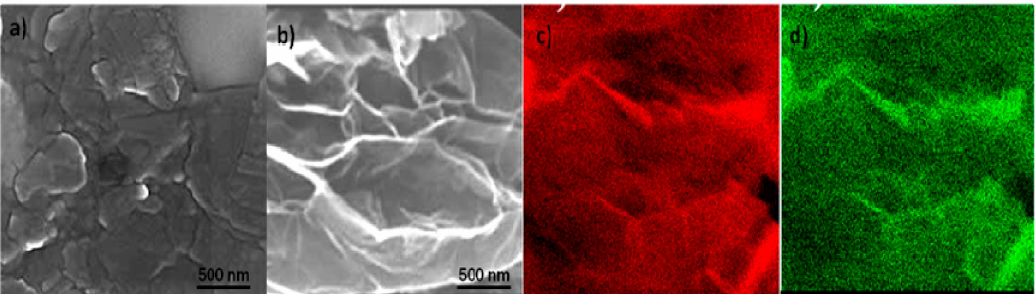
Figure 2. SEM images of pristine FGF ( a ), EGO 14, ( b ) and the EDX maps of the area shown in b for carbon ( c ) and oxygen ( d ).